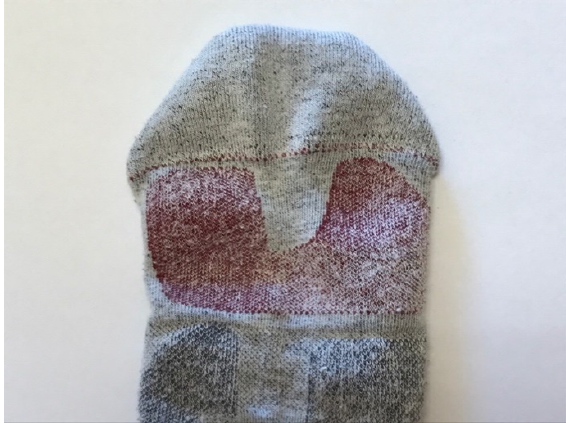
Figure 2. Metatarsal cushioning of the experimental sock.